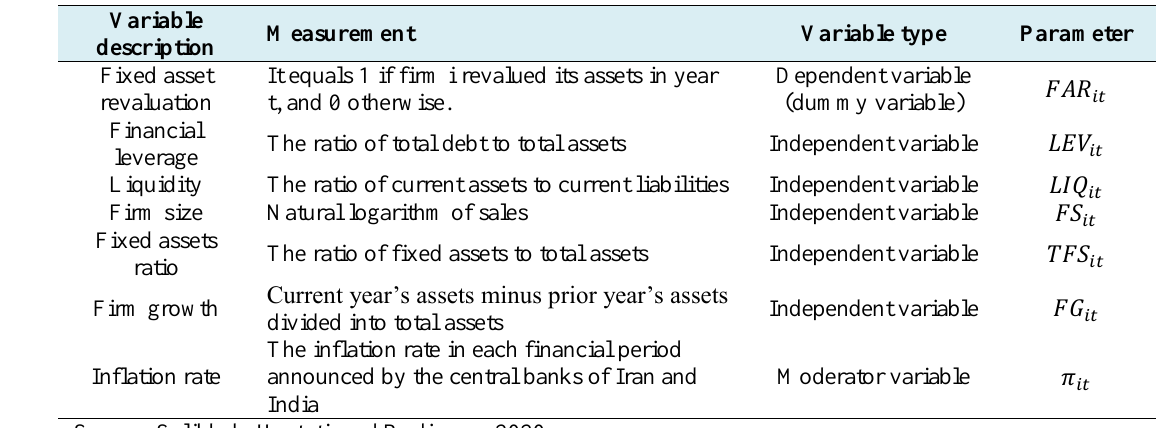
Table 1. Measurement of Research